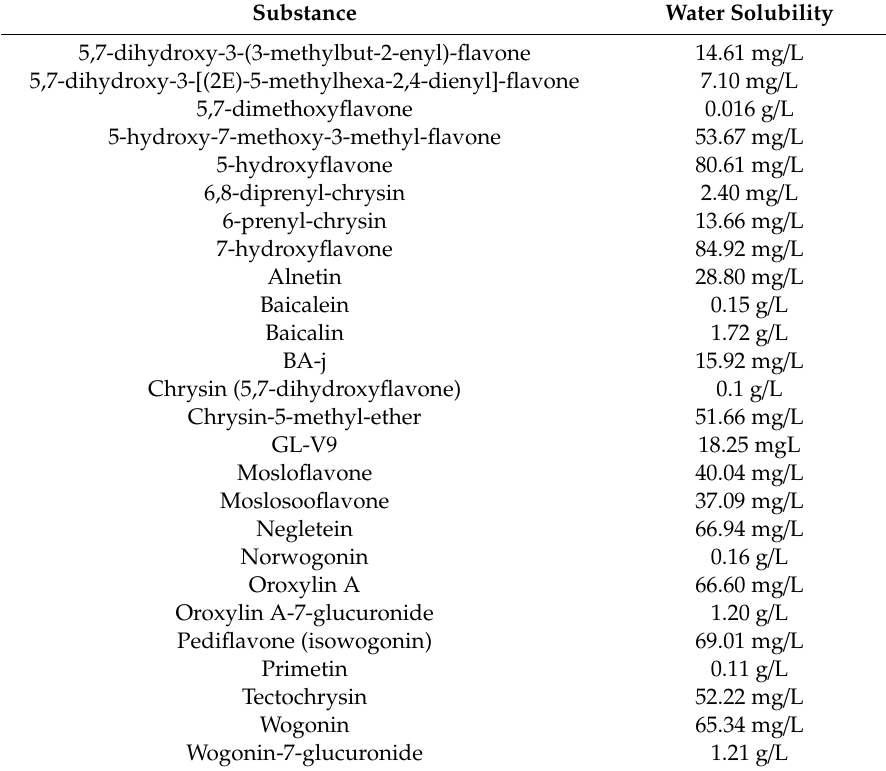
Table 1. Solubilities for most known unsubstituted B-ring